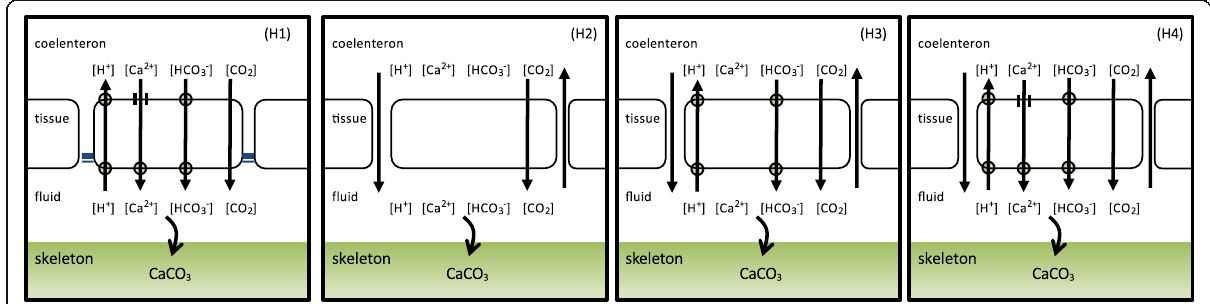
Fig. 9 Different ion transport hypotheses tested in this study and their simulation results (Hohn and Merico 2015). (H1) transcellular ion transport only, (H2) paracellular ion transport only, (H3) proton flux hypothesis, and (H4) combination of transcellular and paracellular ion transport. The upper panels visualize the conceptual models of the different transport hypotheses (H1 – H4). Ca 2+ is transported into the cell through the Ca 2 + -channel, whereas it is transported into the calcifying fluid from the cell by the Ca-ATPase